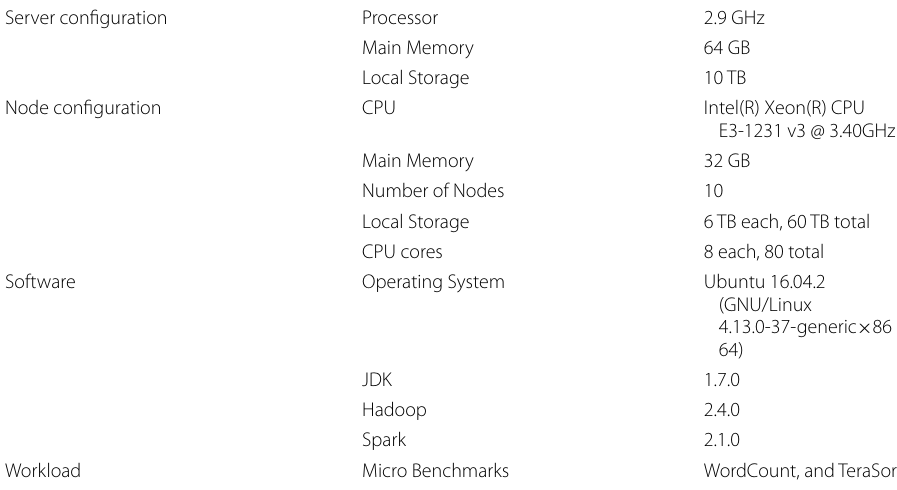
Table 2 Experimental Hadoop cluster Server